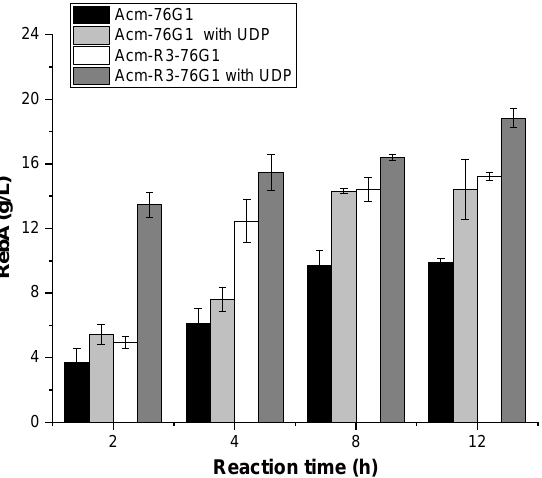
Figure 4. The influence of UDP (2 mM) supplement on RebA production catalyzed by Acm-76G1 and Acm-R3-76G1. The reaction mixture (10 mL), consisting of approximately 15 mg/mL of the crude extract, 20 g/L stevioside, 400 g/L sucrose, and a certain concentration of UDP, was incubated at pH 7.2 and 50 °C.